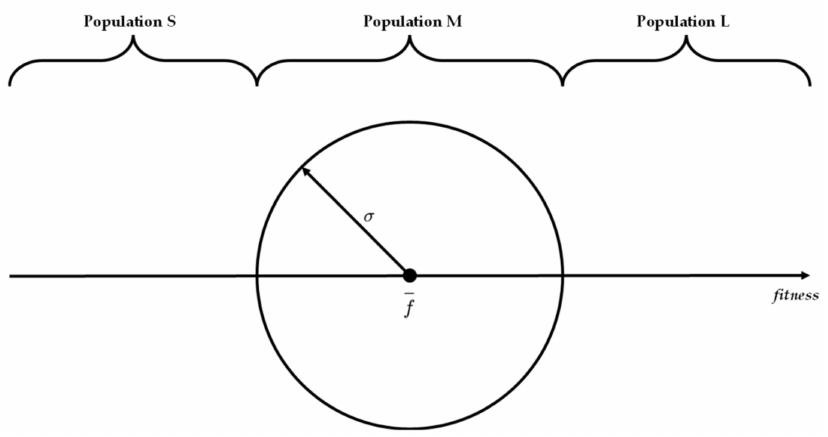
Figure 4. Population